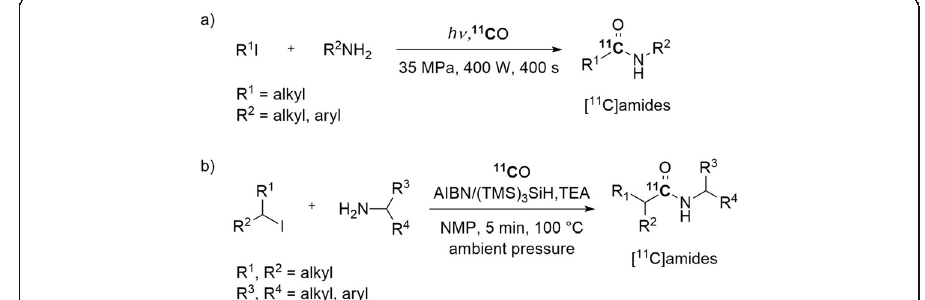
Fig. 15 Radical 11 C-cabonylation of substrates with β -hydrogens: a at high pressure; b at ambient pressure